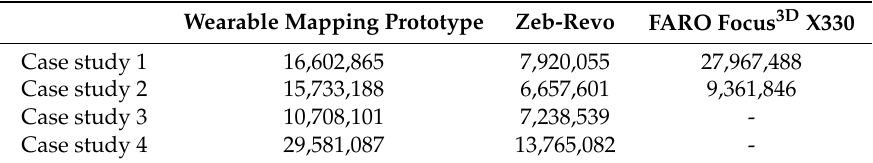
Table 4. Data acquisition per system and case study scenario (number of